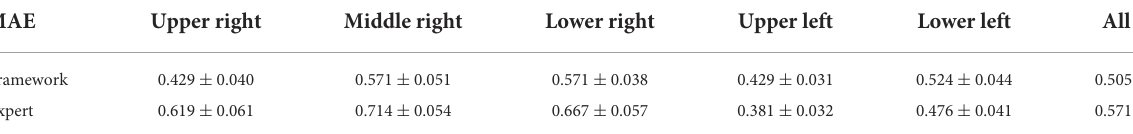
TABLE 5 Model and expert (two resident radiologists) MAE error for different lung lobes over the 21 scans of our test sets. MAE Upper right Middle right Lower right Upper left Lower left All lobes